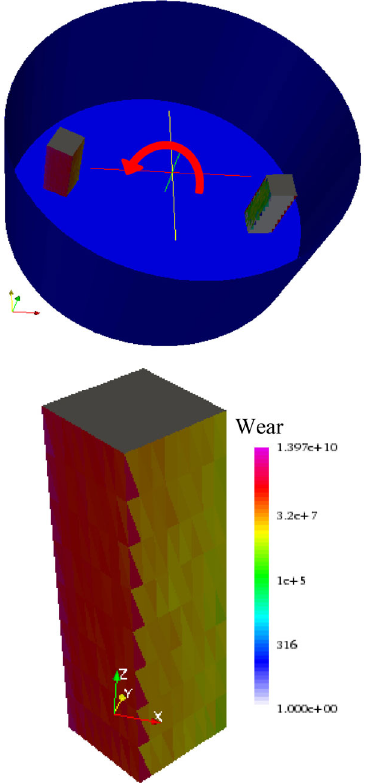
Fig. 13 Location of the samples inside the container filled with particles and contours of the erosive wear on the sample surfaces. ( d = 0.6 mm and two surface orientations are  80° and  60°; The particles are